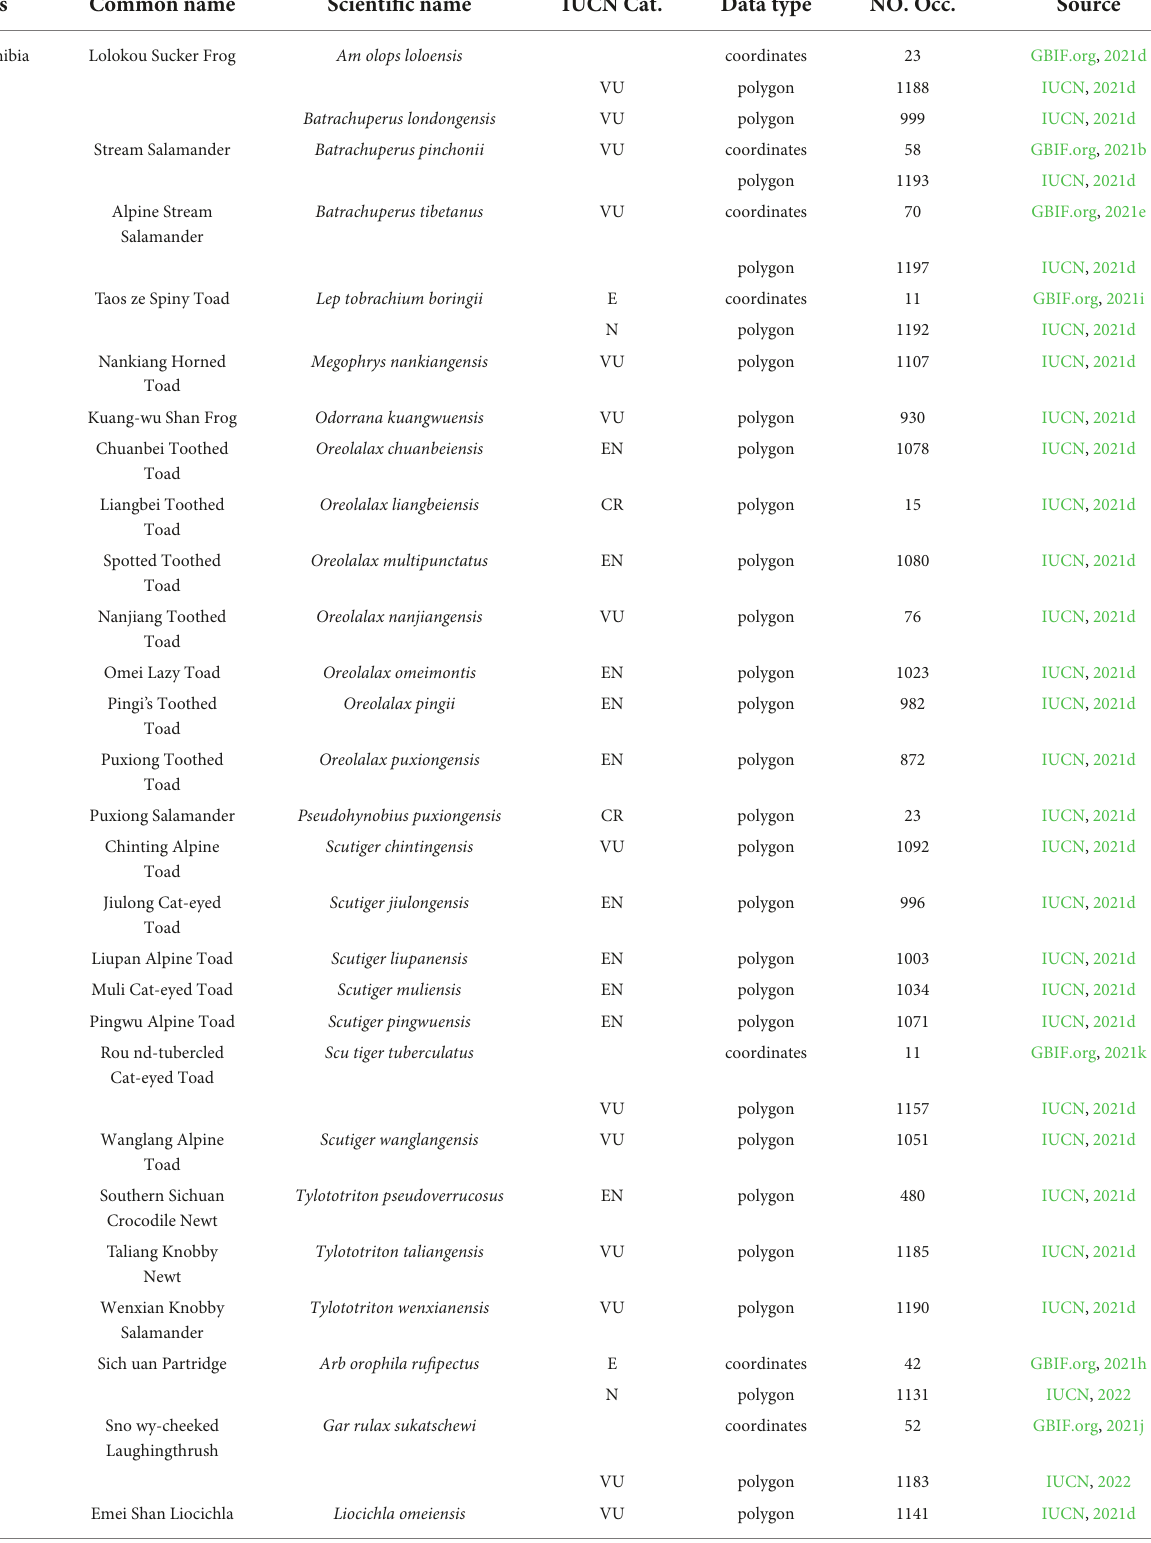
TABLE 1 Species list and summary of occurrence